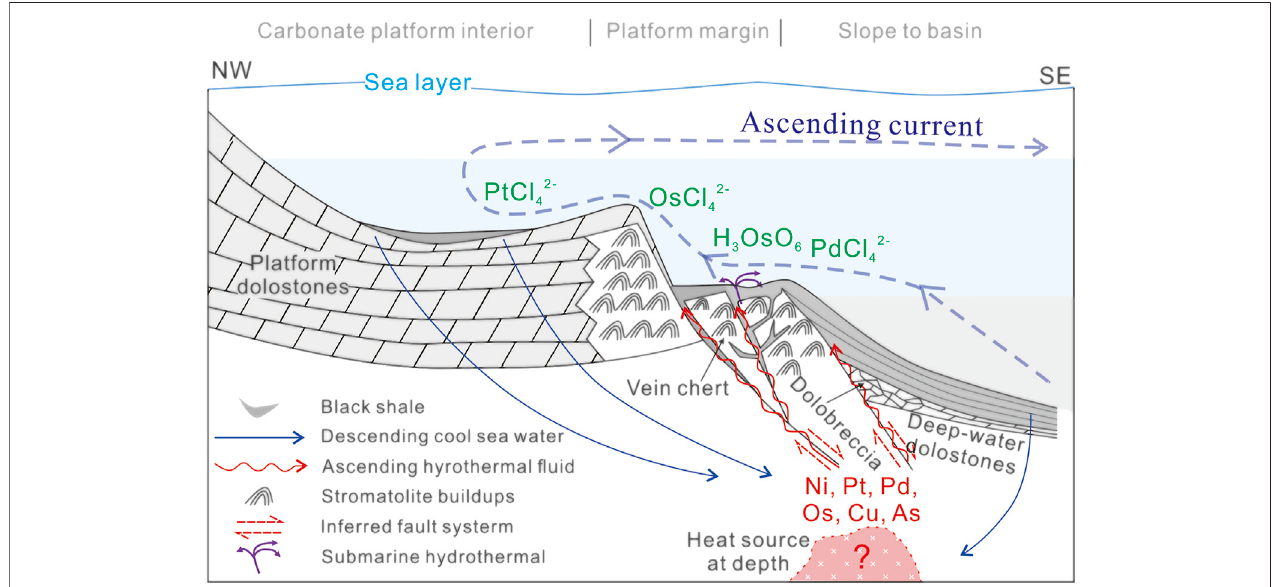
FIGURE 9 | PGE metallogenic model for the Cambrian polymetallic layer in South China (after Wang et al., 2012; Li et al., 2020).